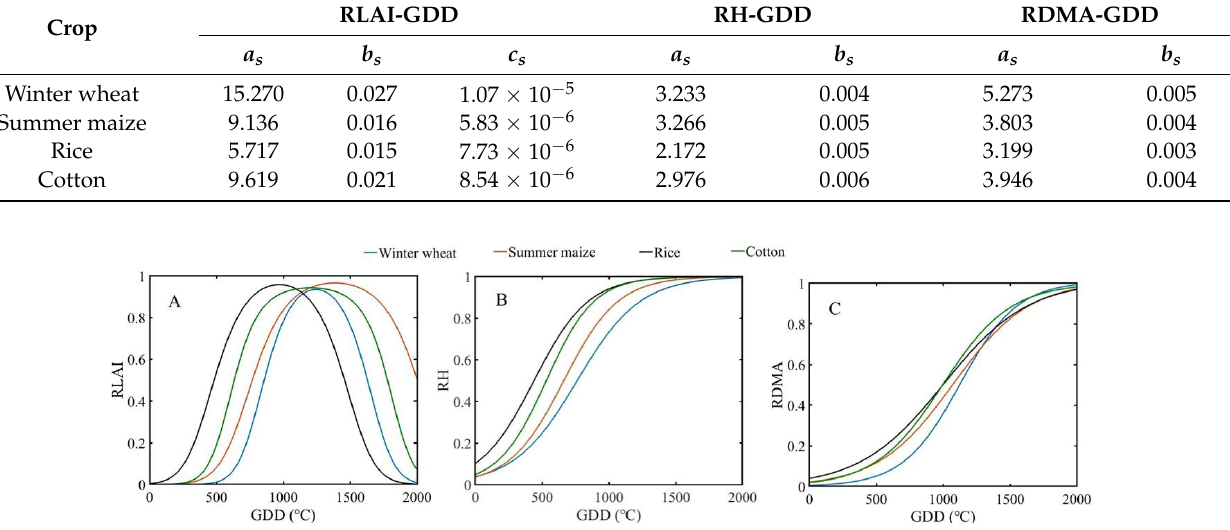
Table 10. Parameters of the Semirelative Logistic Model for the Indices of Crop Growth. RLAI-GDD, RH-GDD, and RDMA-GDD are the logistic models between RLAI and GDD, RH and GDD, and RDMA and GDD, respectively. a s , b s , and c s are parameters of the semirelative logistic growth model. c s = 0 in the relationship between RH-GDD and RDMA-GDD.